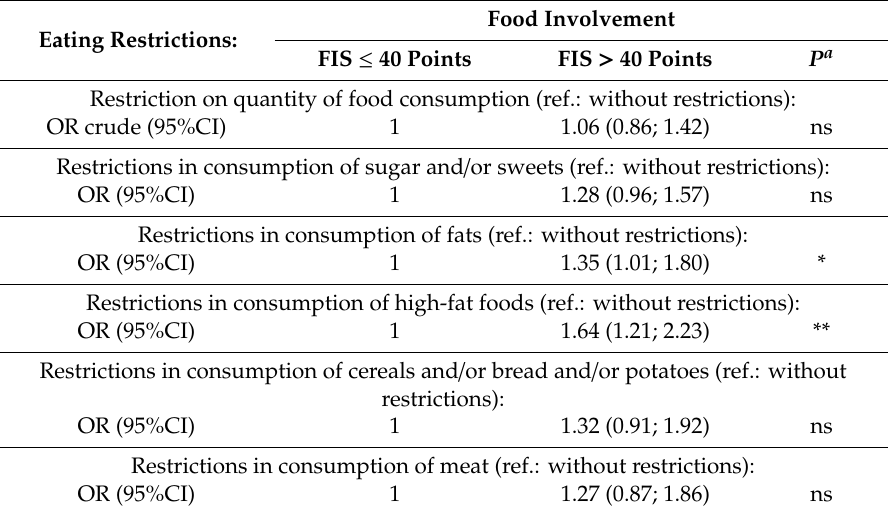
Table 5. Odds ratio (OR (95% CI) of food involvement by eating restrictions in Polish